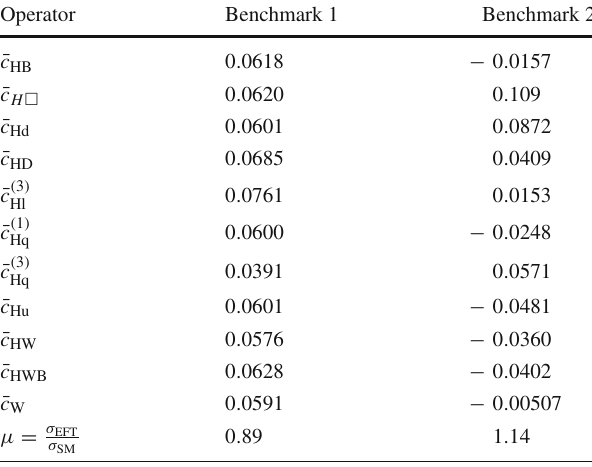
Table 1 Benchmarks for bosonic operators. ¯ c i = c i v 2 (cid:2) of significant digits used has been reduced in this table for the purpose of clarity. The CP-violating operators {¯ c (cid:7) set to